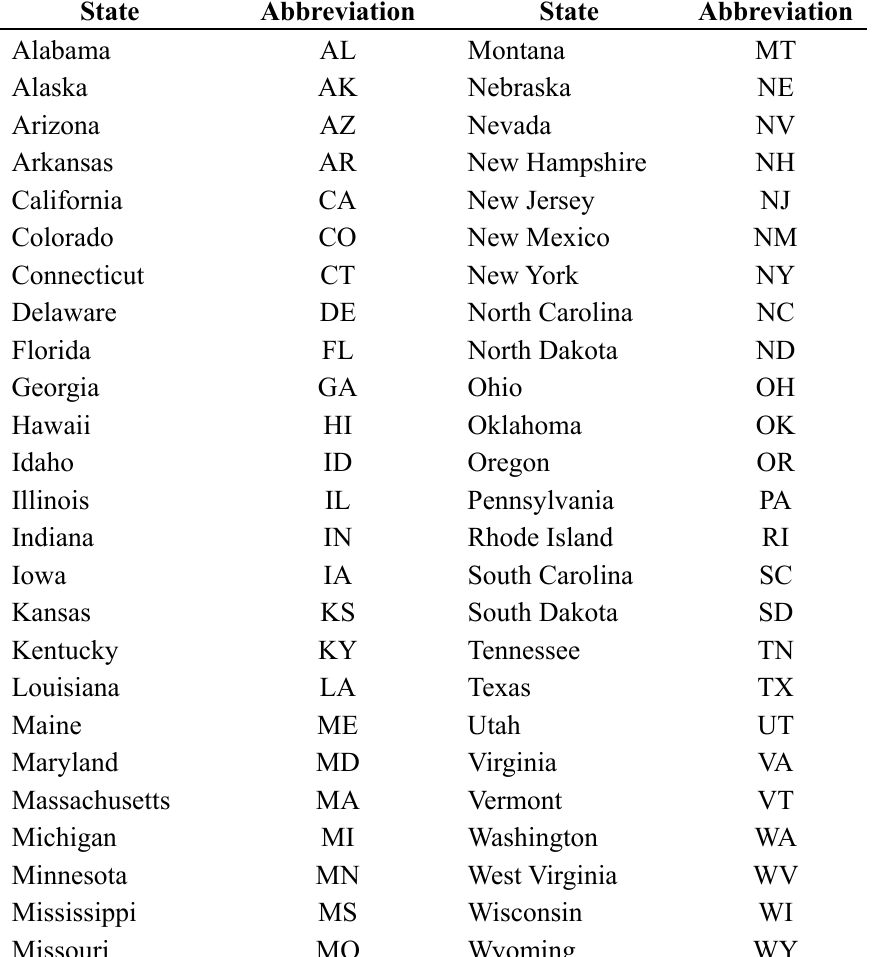
Table A1. Abbreviation of the states in the USA (by alphabetic